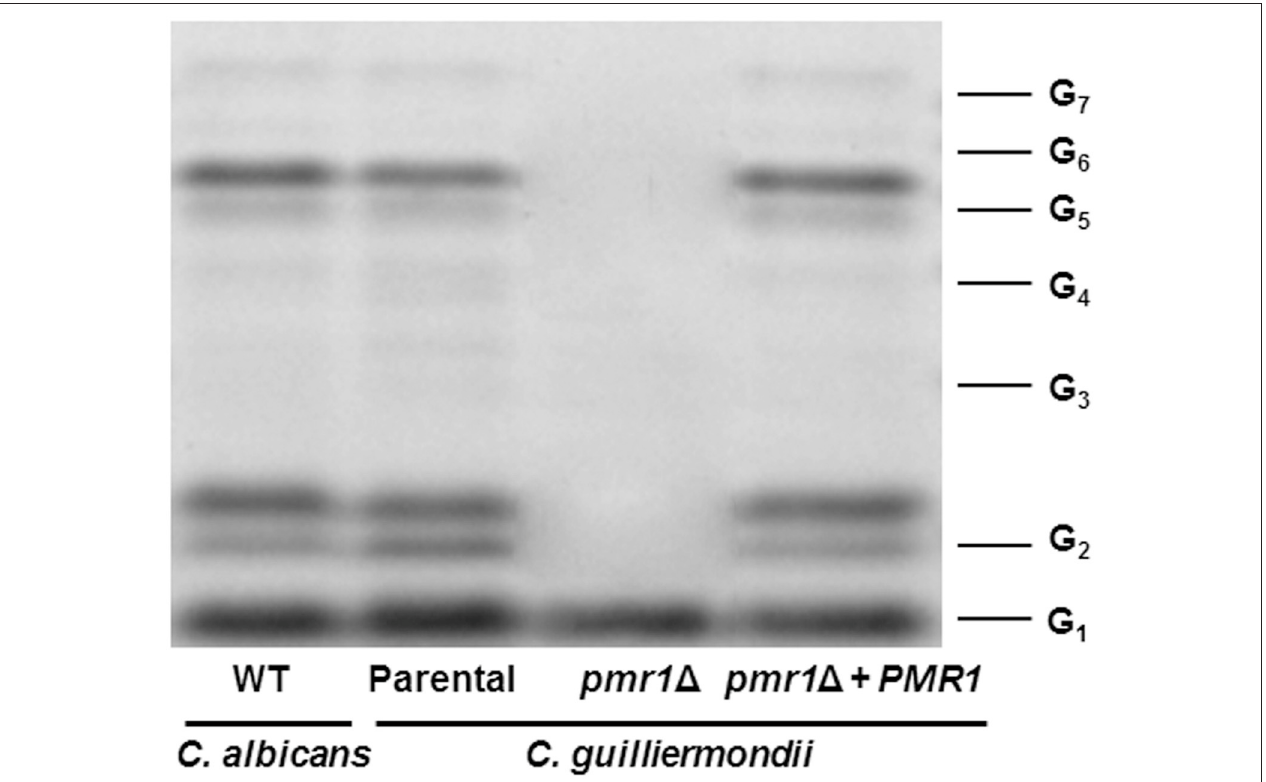
FIGURE 7 | Fluorophore-assisted carbohydrate electrophoresis of O- linked mannans. Upon β -elimination, O -linked mannans were derivatized with 8-aminonaphthalene-1,3,6-trisulfonic acid and sodium cyanoborohydride and separated in a 35% (w/v) polyacrylamide gel under non-denaturing conditions. The image is representative of three independent experiments. The strains used are NGY152 (WT) KU141 (Parental), HMY134 ( pmr1 1 ), and HMY138 ( pmr1 1 + PMR1 ). The molecular marker used was a ladder of maltooligosaccharides from one (G1) to seven (G7) glucose units.